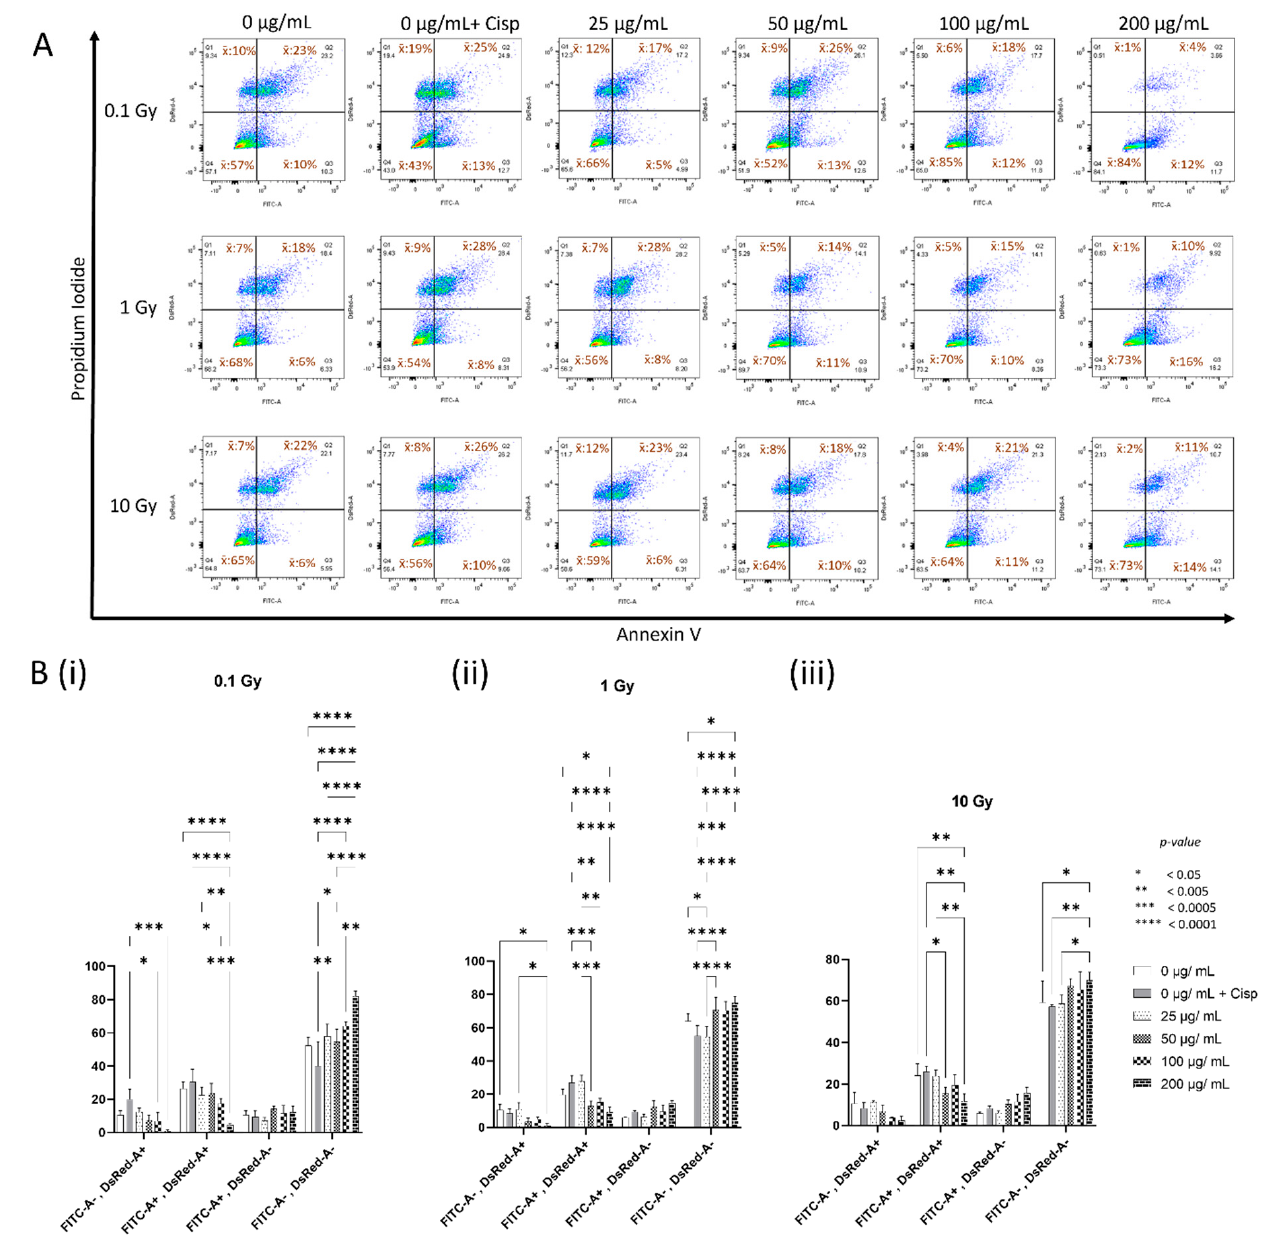
Figure 3. Concentration-dependent modulation of cellular health by CeO 2 nanoparticles in MDA MB231 breast carcinoma cells following irradiation with ionizing radiation. ( A ). Four-quadrant gating of viable (AV − /PI − ), early apoptotic (AV + /PI − ), apoptotic and necrotic (AV + /PI + ), and already dead (AV − /PI + ) cells not treated or treated with cisplatin, 25, 50, 100, or 200 μ g ml − 1 nanoceria, analyzed for green fluorescence (Annexin V, FL1-A) and red fluorescence (Propidium Iodide, FL2-A) following 0.1, 1, or 10 Gy irradiation. ( B ). A two-way ANOVA was used to compare the background-subtracted median fluorescent intensities of different treatment samples within each FL1A/FL2A gated quadrant population irradiated with ( i ) 0.1 Gy, ( ii ) 1 Gy, or ( iii ) 10 Gy ionizing